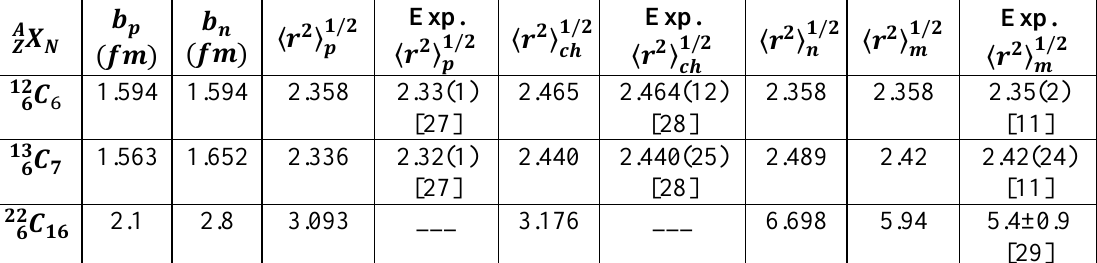
Table 6: Calculated proton, charge, neutron, matter radii in Fermi’s for stable Carbon isotopes 12 C, 13 C, by using LST technique compared with available experimental data.